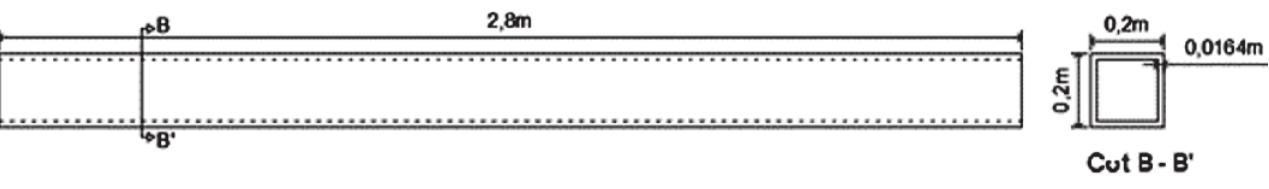
Figure 4 Longitudinal view and cross section of the prototype GFRP